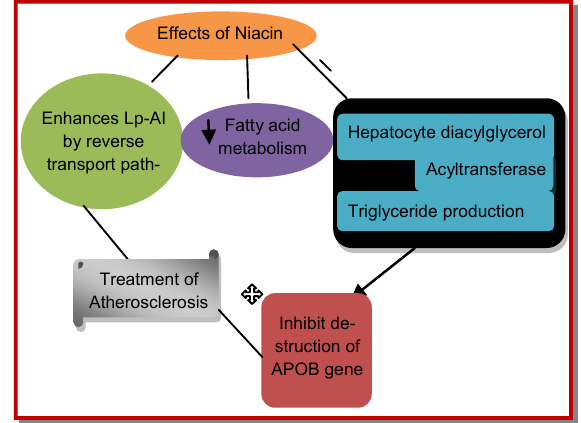
Figure 3: Niacin plays a role for the enhancement of Lp-Al by reverse transport pathway, decrease fatty acid metabolism like hepatocyte diacylglycerol, acyltransferase, and triglyceride production. These lipid control factors inhibit the destruction of APOB gene. This APOB gene and level of Lp-Al collectively control the